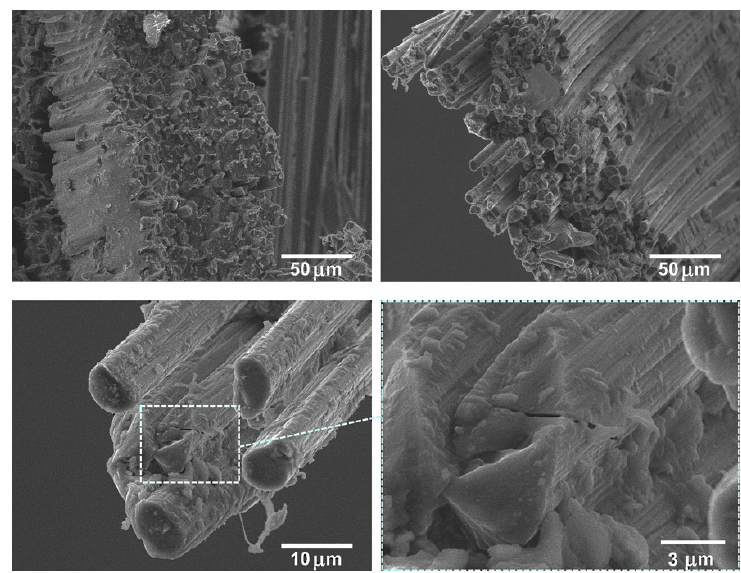
Figure 8. The structure of the carbon fiber/polysulfone composites (60/40 wt %) reinforced with surface modified carbon fibers (TO 500 °C, 30 min) after the tensile tests.